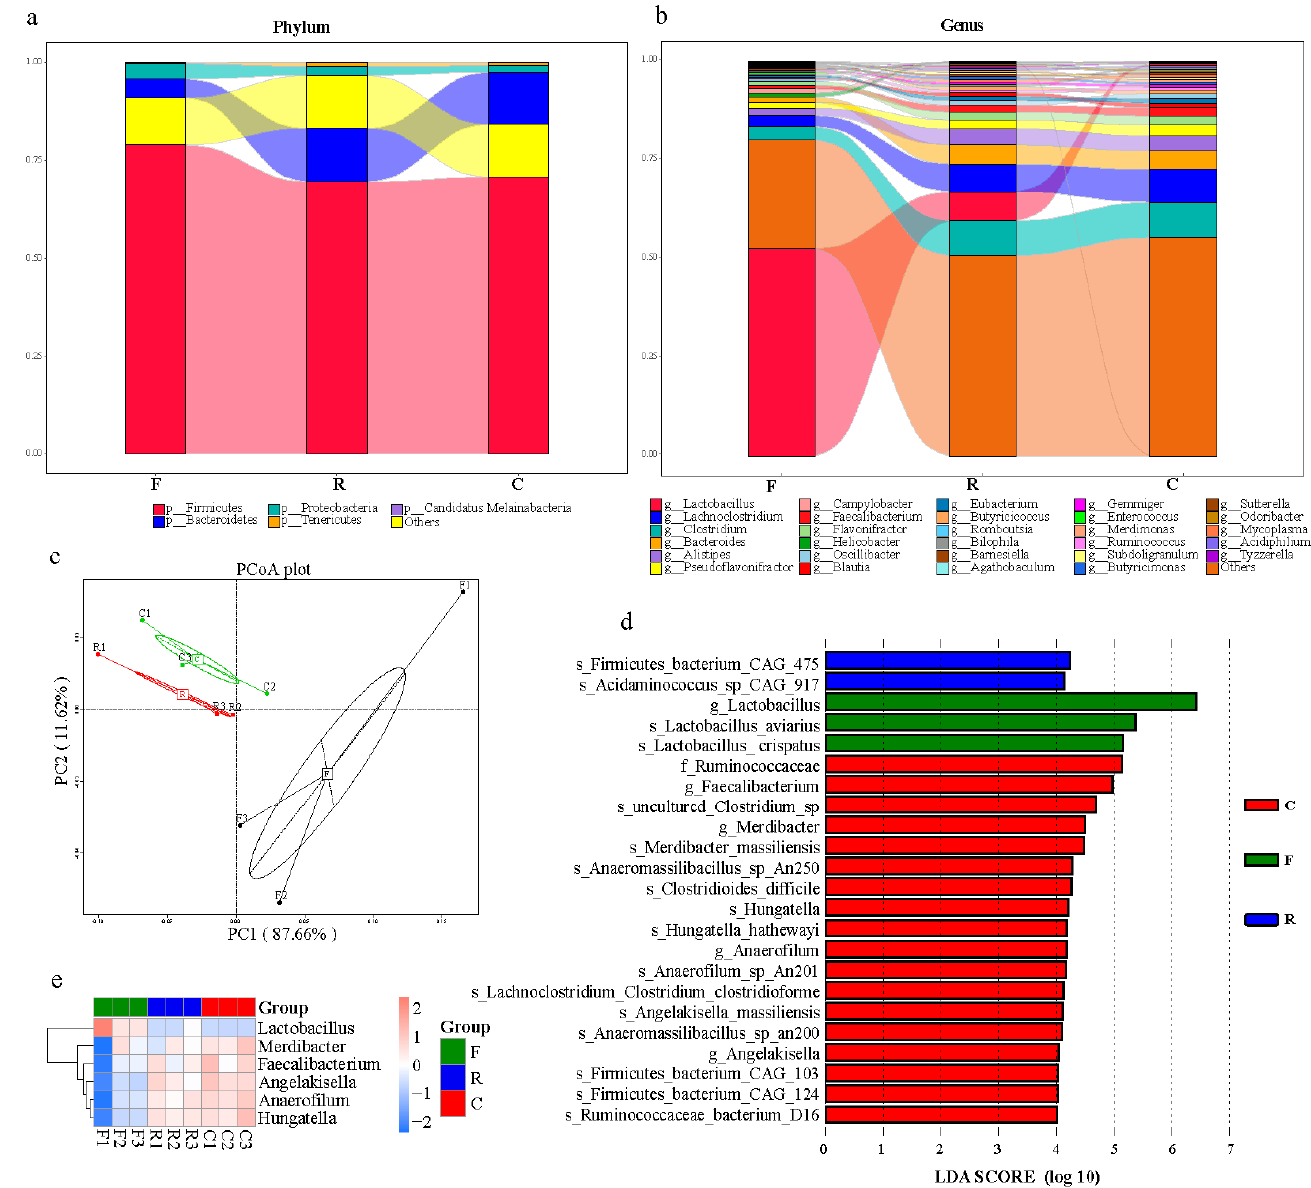
Figure 1. Microbial community structure from different sampling resources. ( a ) Relative abundance of dominant microbial phyla in different sampling resources. ( b ) Relative abundance of most abundant microbial taxa at the genus level in different sampling resources. ( c ) Principal coordinate analysis plot generated using abundance at different taxonomic levels based on Bray–Curtis dissimilarities. Each plot represents a sample. ( d ) LDA distribution histogram identified by the LEfSe algorithm. Only taxonomic biomarkers (LDA score > 4) are presented. ( e ) Clustering of taxonomic biomarkers based on LEfSe results. F, feces; C, cecal chyme; R, rectal chyme (inner cloacal chyme).